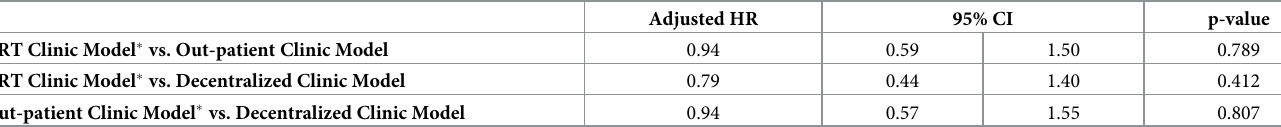
Table 4. Cox regression analyses comparing the